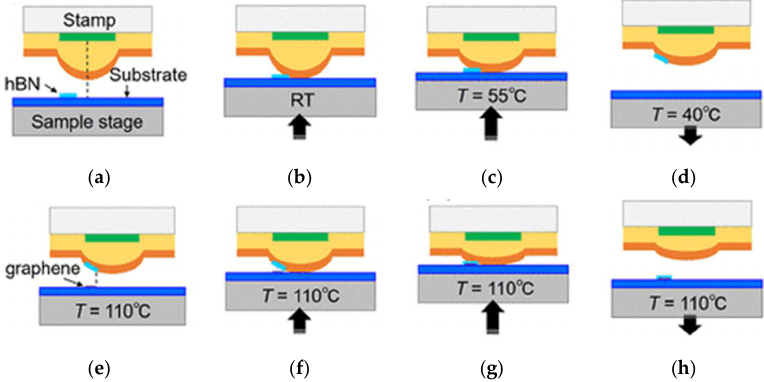
Figure 12. Schematic illustration of the transfer process flow [69]. ( a ) h-BN flake on a SiO 2 /Si sub- strate; ( b ) center ofthe stamp begins to contact with the substrate; ( c ) circular contact area covers the h-BN flake. ( d ) picked up h-BN flake on the stamp surface ( e ) graphene flake on the substrate; ( f ) stamp having the h-BN flake begins to contact with the substrate having the graphene flake; ( g ) circular contact area covers the graphene flake, so that the h-BN flake is overlapped with the gra- phene flake; ( h ) h-BN/graphene stack.